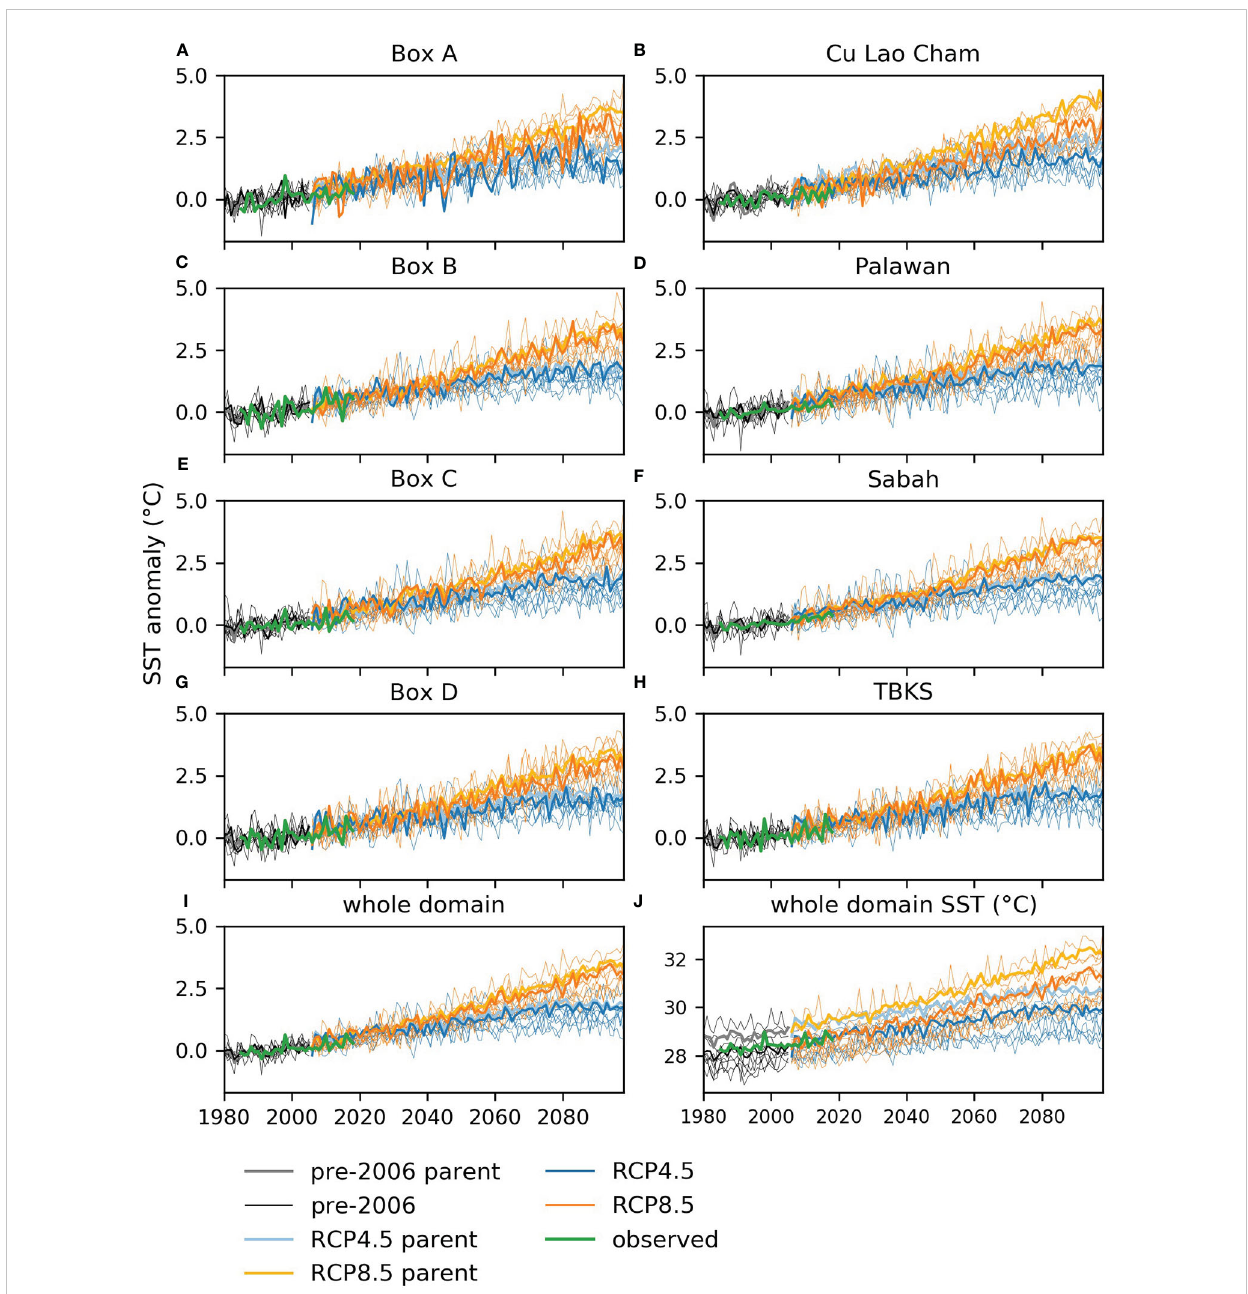
FIGURE 3 Annual mean sea surface temperature for the sample areas de fi ned in Figure 1: (A-I) anomalies compared to the mean for 1980-2005 averaged over sample areas and the whole domain and (J) annual average for 1980-2098 for the whole domain. The darker lines show the regional model outputs, the paler color lines show the parent global model, the thinner lines show a range of other CMIP5 models. In each case the black lines show the CMIP5 historical period, 1980-2005, the blue lines RCP4.5 and the orange lines RCP8.5. The green line shows satellite-based values, see section 2.6 for product